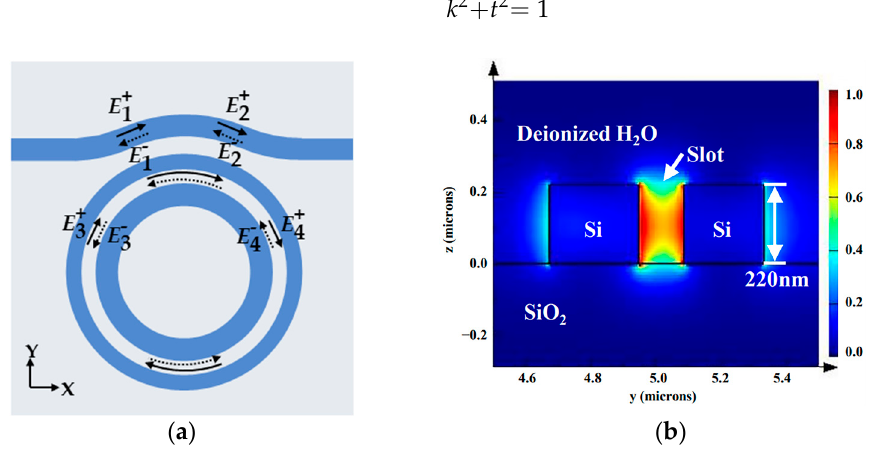
Figure 2. ( a ) Light field propagation inside the SMRR sensor. ( b ) Mode profile for fundamental quasi-TE mode inside slot microring waveguide in deionized water